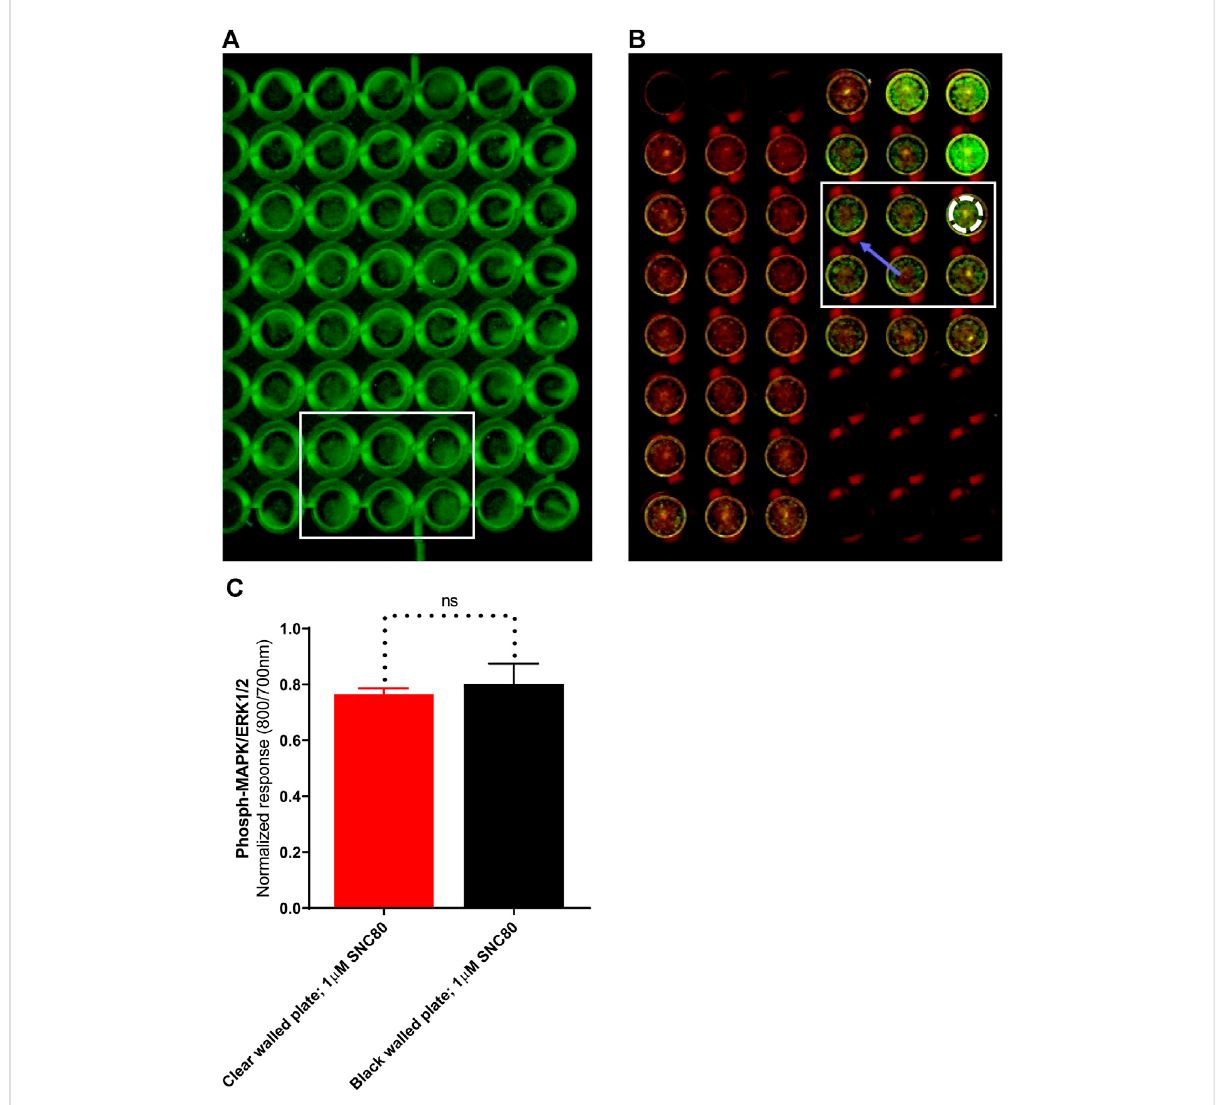
FIGURE 4 Images of randomly selected wells from (A) black-walled or (B) clear-walled 96-well plates seeded with 25,000 cells/well. The blue arrow indicates the presence of scattered light near-infrared fl uorescence in the dead zone between the wells. (C) Phospho-ERK response in SNC80treatedcellsinclearandblack-walledassayplates,stimulatedwith1 µM;5 min).ns p > 0.05(unpairedtwo-tailedt-test).Differentialeffectsof DOPr agonists in the presence or absence of